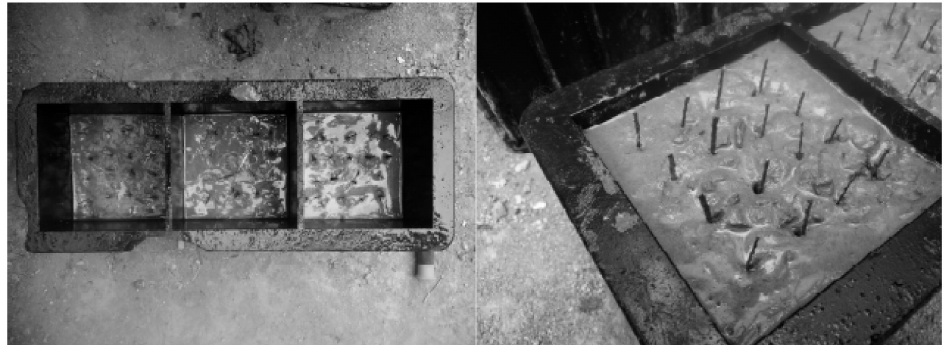
Figure 2. Arrangement of the steel fibers in the concrete.